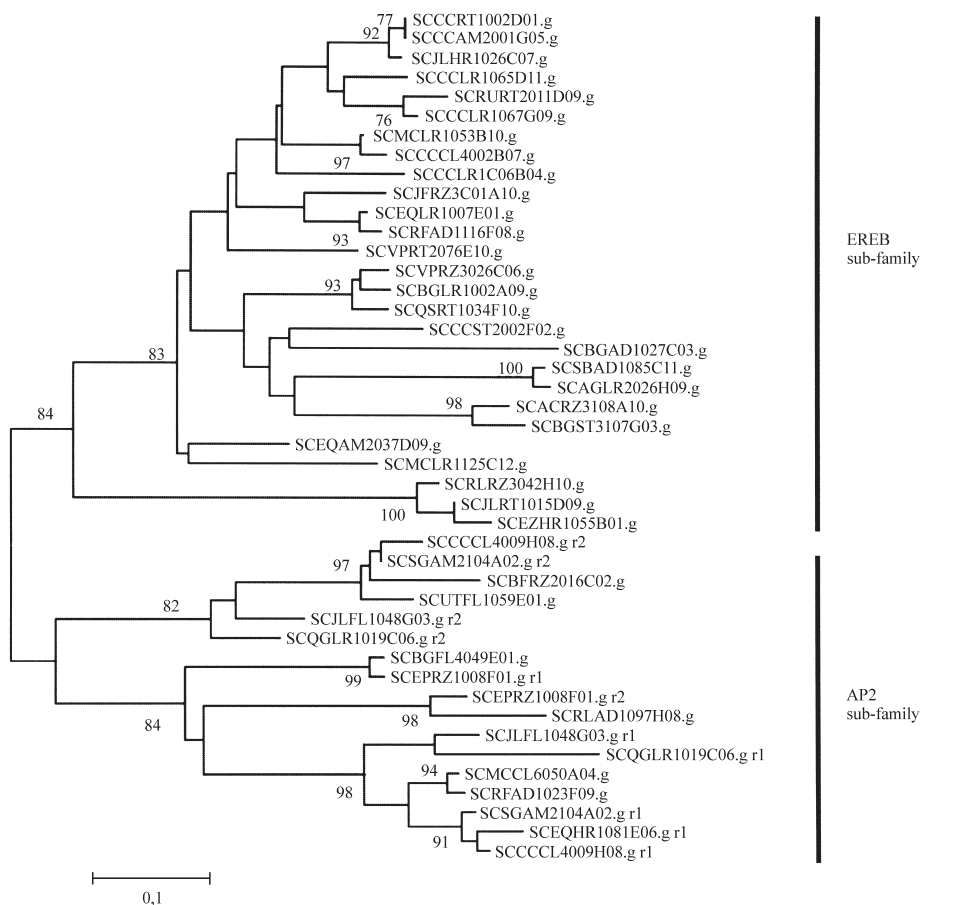
Figure 5 - Phylogenetic relationships among sugarcane nucleotide sequences coding for the AP2 domain. The most parsimonious consensus tree had its branches scaled to the corresponding genetic distances. Only Bootstrap values (1000 replicates) higher than 75% are